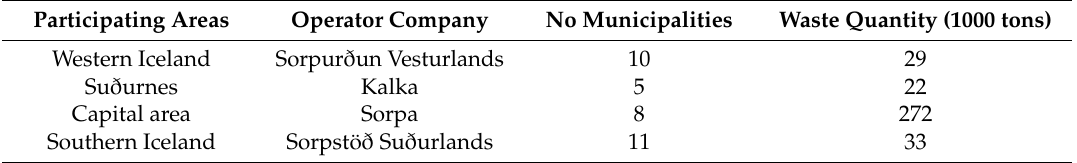
Table 1. Information regarding waste operation in the main parts of Iceland in